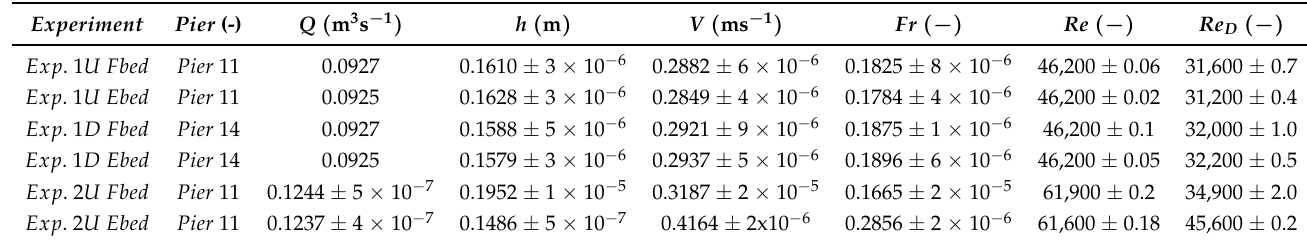
Table 1. Hydraulic variables of the fixed bed